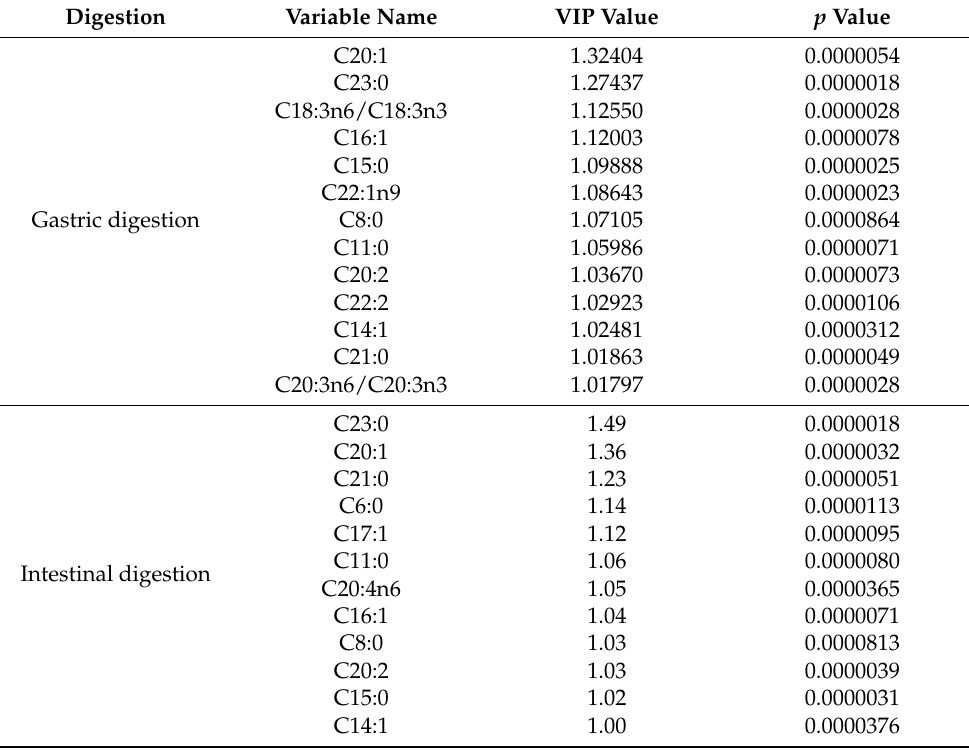
Table 3. Differential fatty acids of infant formulas and human milk during